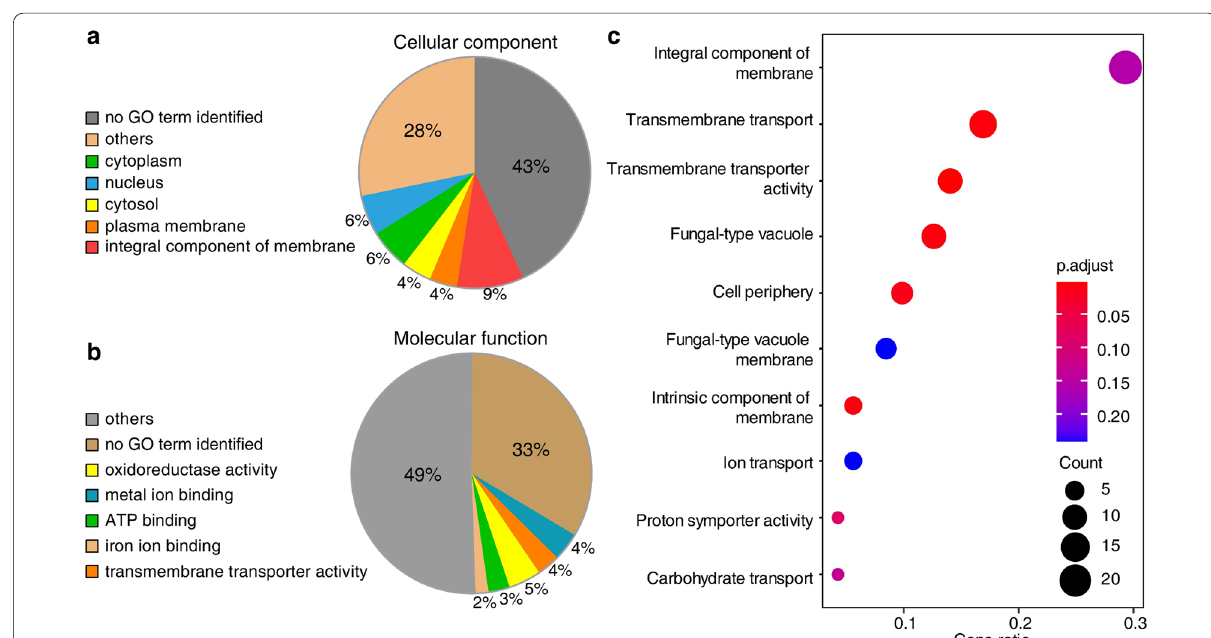
Fig. 8 Functional classification of differentially expressed genes (DEGs) between the Δ FocGCS mutant and the WT strain. a DEGs assigned to cellular component categories according to the Gene Ontology Consortium database. b DEGs assigned to molecular function categories according to the Gene Ontology Consortium database. c The most significantly enriched GO terms according to the gene ratio. A circle indicates the target genes that are involved. The size of the cycle indicates the number of genes. The coloring of the P ‑values indicates the significance of the gene ratio. The Y‑axis shows the enriched GO term. The X‑axis represents the gene